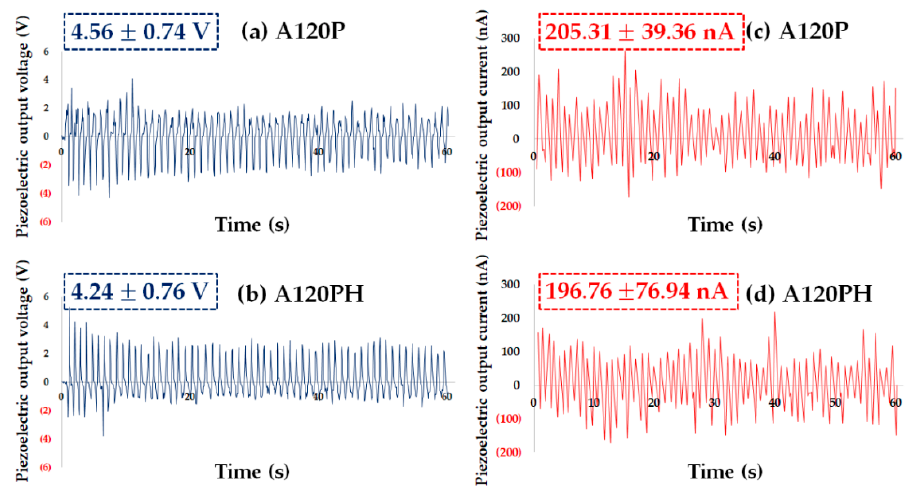
Figure 7. Piezoelectric output voltage of ( a ) a sample treated with an NaOH solution and followed by PPy polymerization (A120P) and ( b ) a sample treated with an NaOH solution and followed by PPy polymerization and hydrophobic coating (A120PH) and piezoelectric output current of ( c ) A120P and ( d ) A120PH (values on the upper left of each graph are average values of six samples in the peak to peak values).